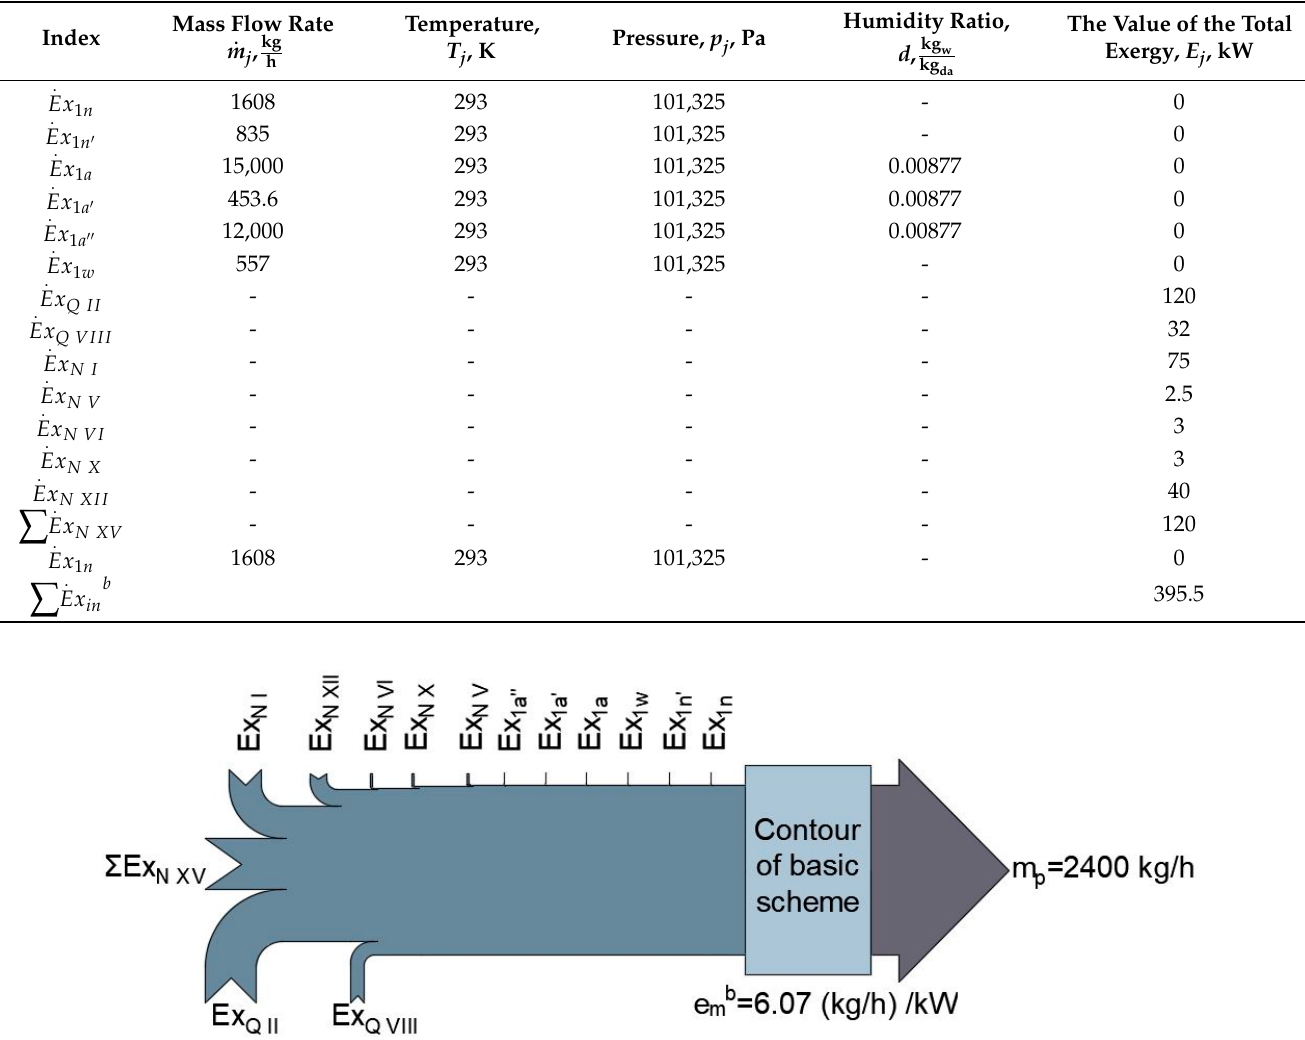
Table 1. The values of exergy crossing the contour of the basic scheme.